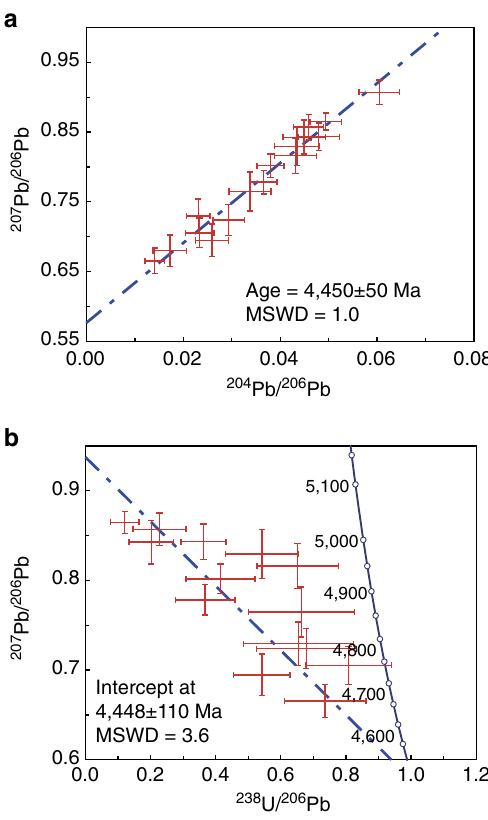
Figure 3 | The result of SIMS U–Pb dating of apatite in DaG 978. ( a ) Inverse 204 Pb/ 206 Pb– 207 Pb/ 206 Pb isochron diagram. ( b ) The projected diagram onto the 238 U/ 206 Pb– 207 Pb/ 206 Pb plane of the total Pb/U isochron in the 238 U/ 206 Pb– 207 Pb/ 206 Pb– 204 Pb/ 206 Pb three-dimension space. All data suggest that the crystallization age of apatite in DaG 978 is 4,450 Myr. The uncertainties for individual analyses are reported as 2 s.d. The 207 Pb/ 206 Pb isochron and total Pb/U isochron ages were calculated at the 95% confidence level. MSWD, mean square of weighted deviated. Figure 2 | Rare earth element patterns of Ca–phosphate minerals from